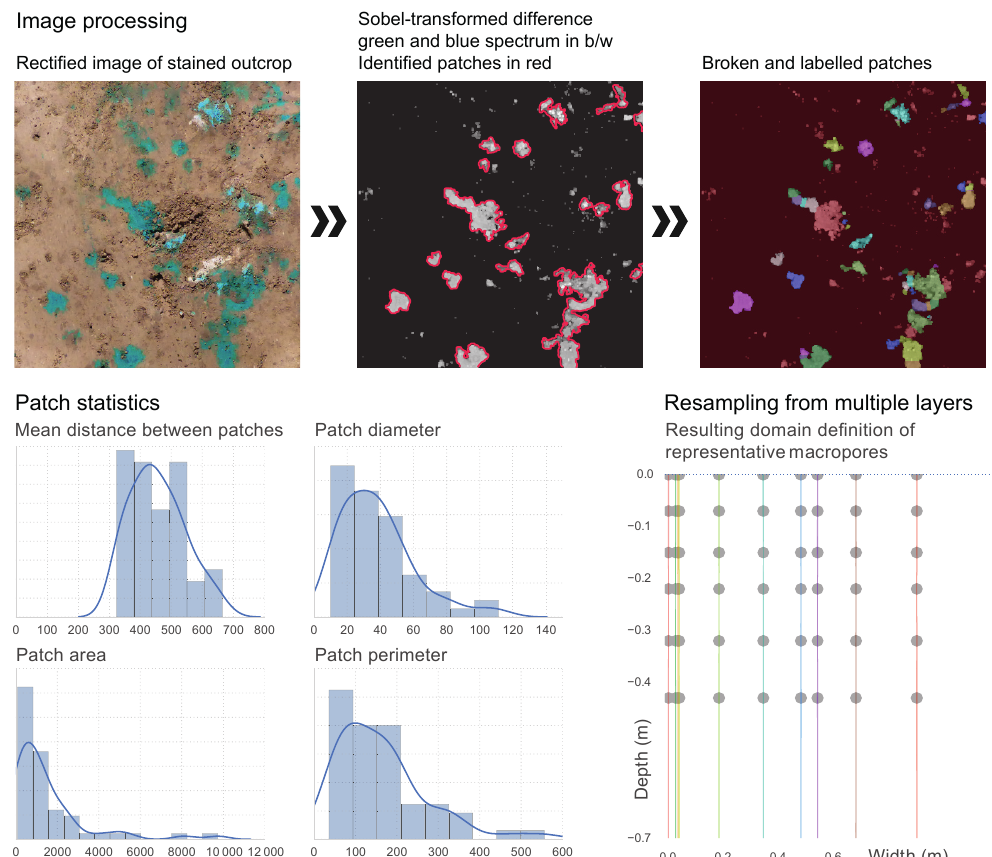
Figure B1. Example of preprocessing of stain images, patch identification and statistics and resulting macropore positions in the representa- tive